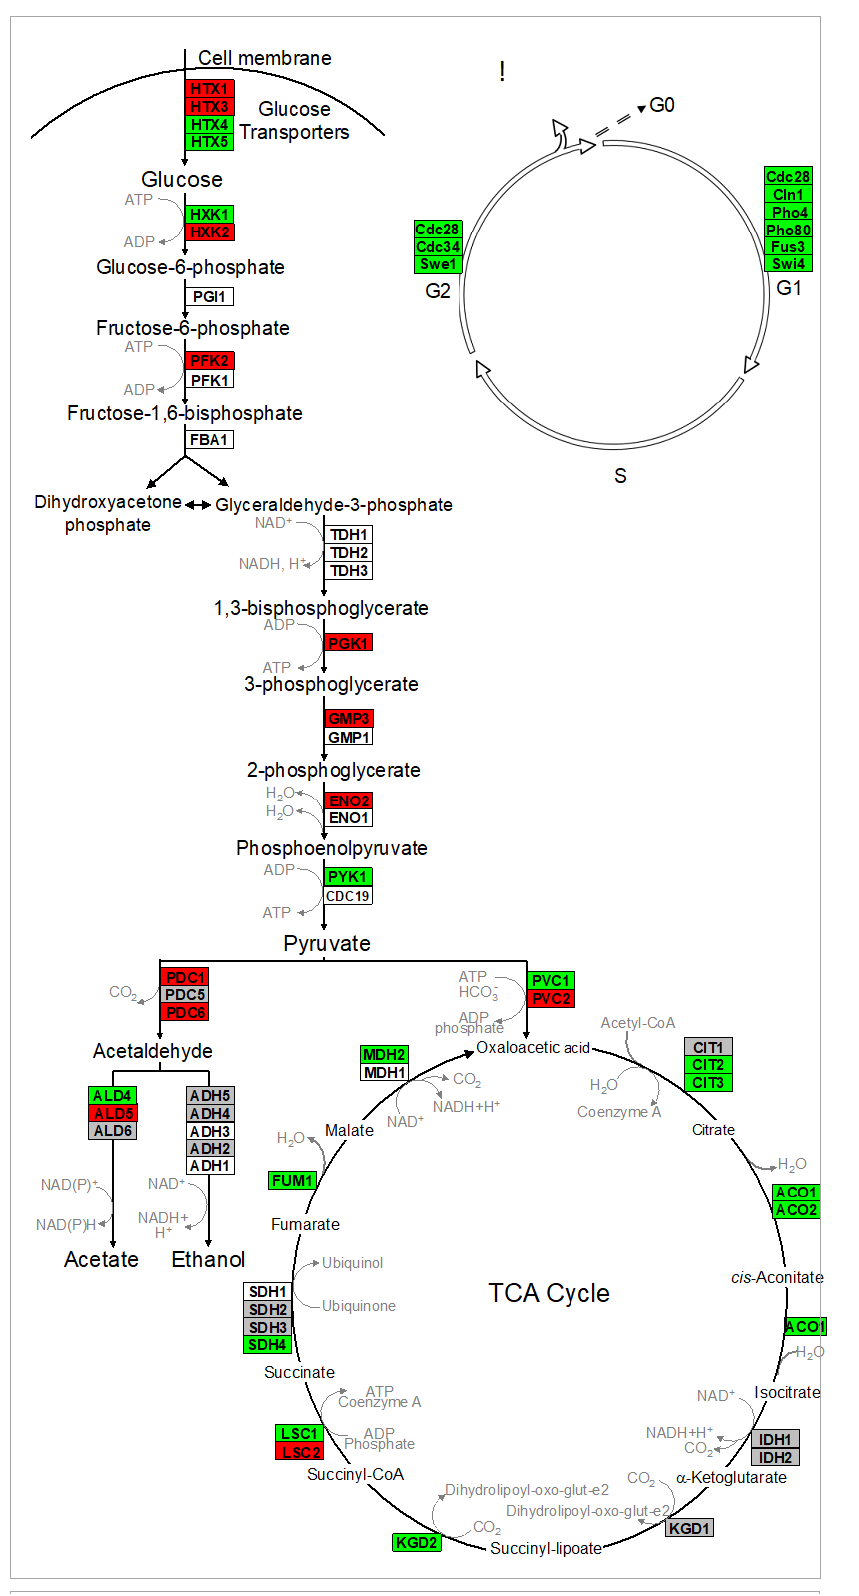
FIGURE 4: Alginate-encapsulated yeast cultured in continuously-fed bioreactors exhibit a stable pattern of gene expression in (A) intermediary metabolism, and (B) cell cycle where transcript abundance of glycolytic genes is increased, and that of TCA cycle and cell cycle genes is decreased. Red indicates genes where expression was at least two-fold greater in encapsulated cells than in planktonic cells over the course of 2 weeks cul- ture. Green indicates instances where those values were at least two-fold less. Gray indicates no significant difference in sign or magnitude be- tween planktonic and encapsulated cells (image adopted from Nagarajan et al . 2014 [132]) OPEN ACCESS | www.microbialcell.com